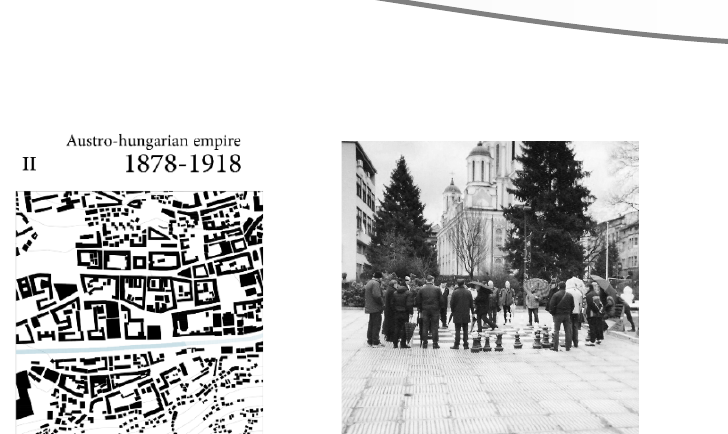
Figure 4: The Austro-Hungarian settlement’s urban form is still visible in the urban layout of the city, as in the public space (Trg oslobođenja – Alija Izetbegović)